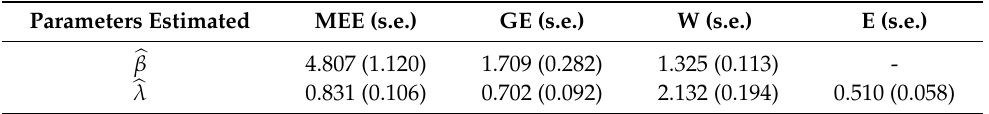
Table 4. ML estimates of the fitted models with their respective standard errors (s.e.). Parameters Estimated MEE